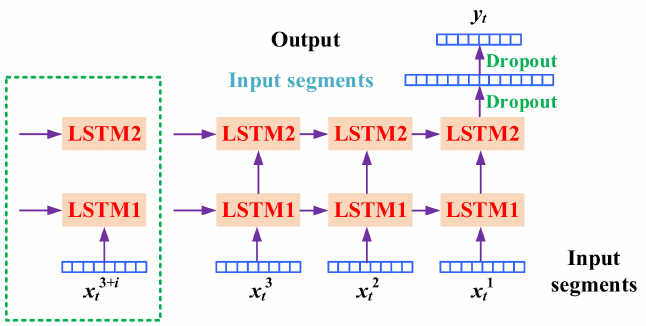
Figure 3. The whole framework of the DL prediction